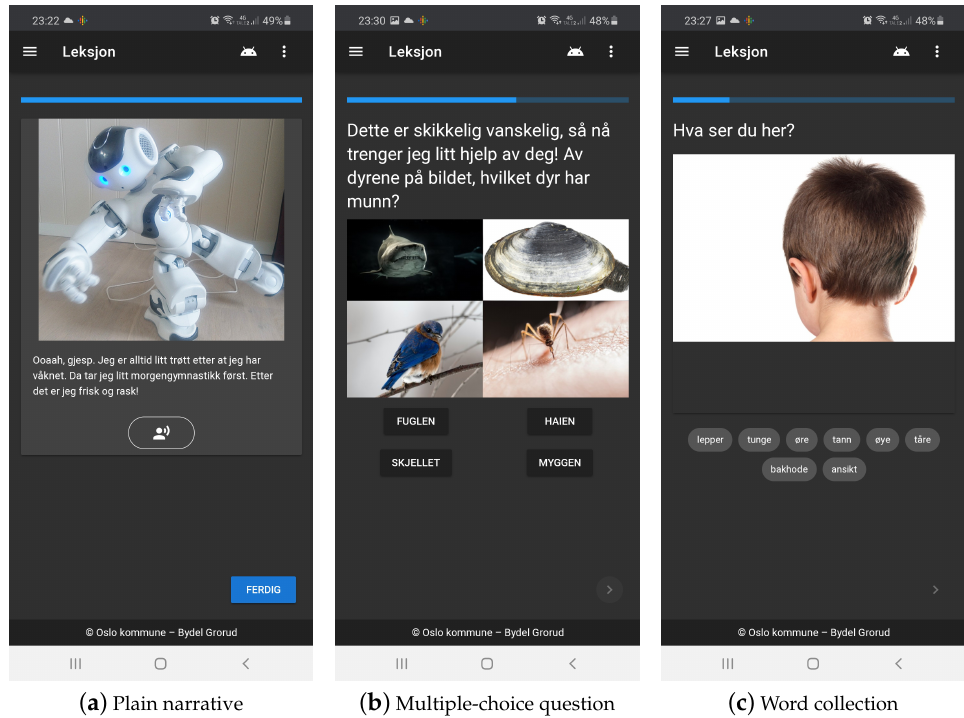
Figure 1. Screenshots of tasks/learning units in the